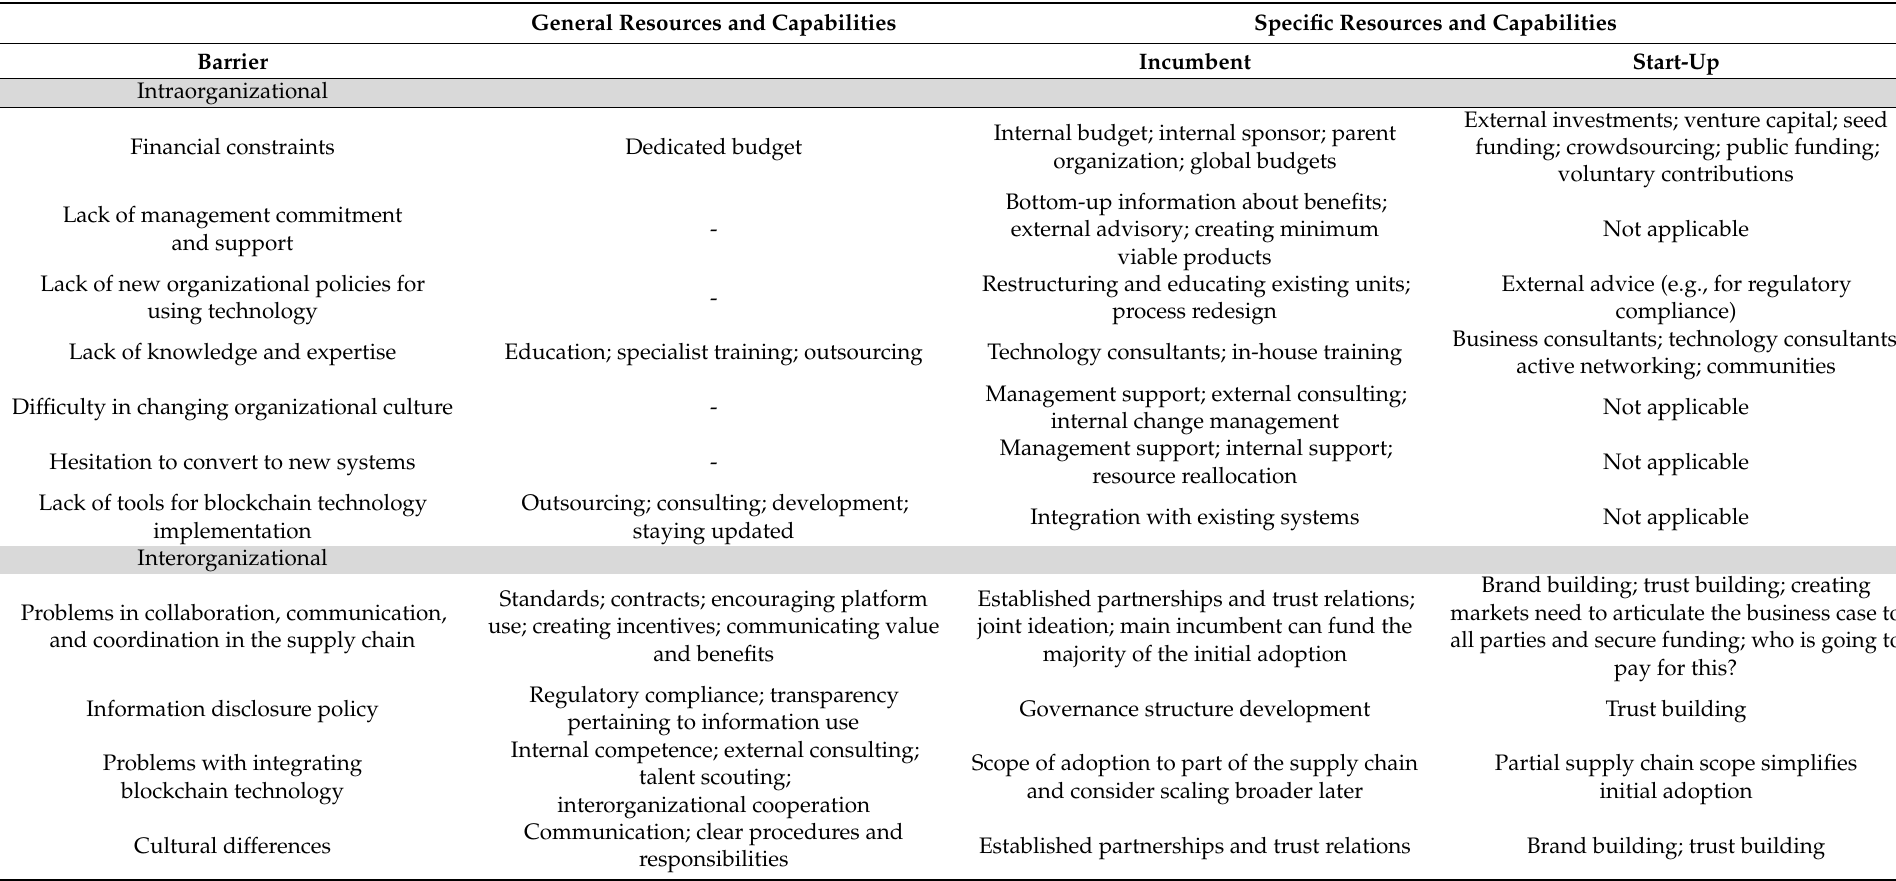
Table 2. Bridging techniques and capabilities to overcome barriers to blockchain adoption in the agrifood